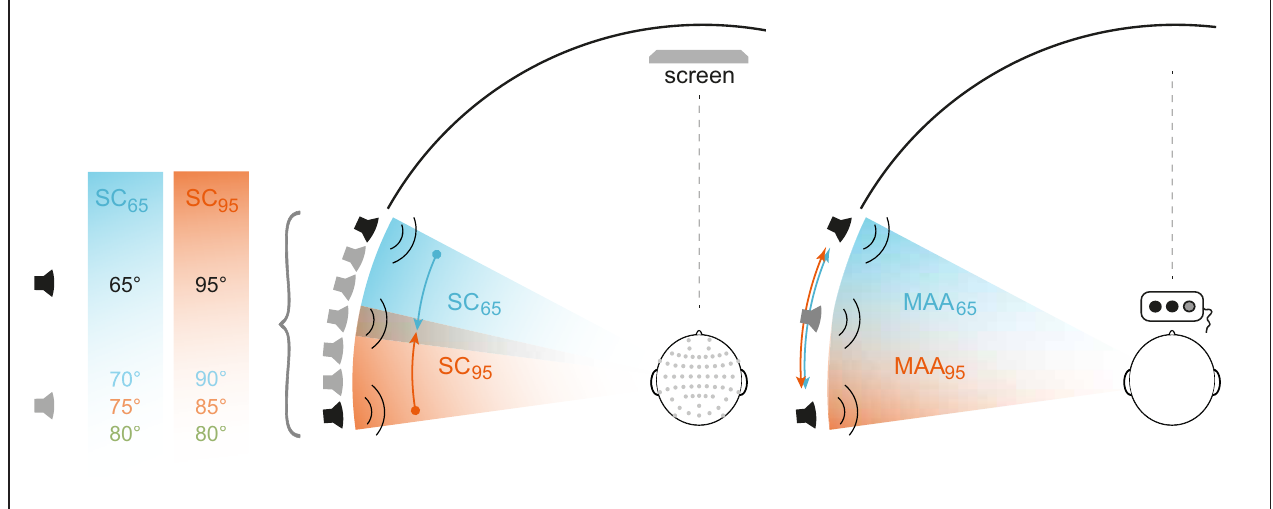
FIGURE 1 | Stimulus design. Experimental setting for EEG (left) and MAA (right) experiments. Two different conditions (blue and orange) were tested differing in the position of the standard/reference stimulus ( − 65 or − 95 ◦ , black loudspeaker symbols). In the EEG experiment a passive oddball-paradigm was used. Three location-deviant signals were presented in each condition (gray loudspeaker symbol) with the